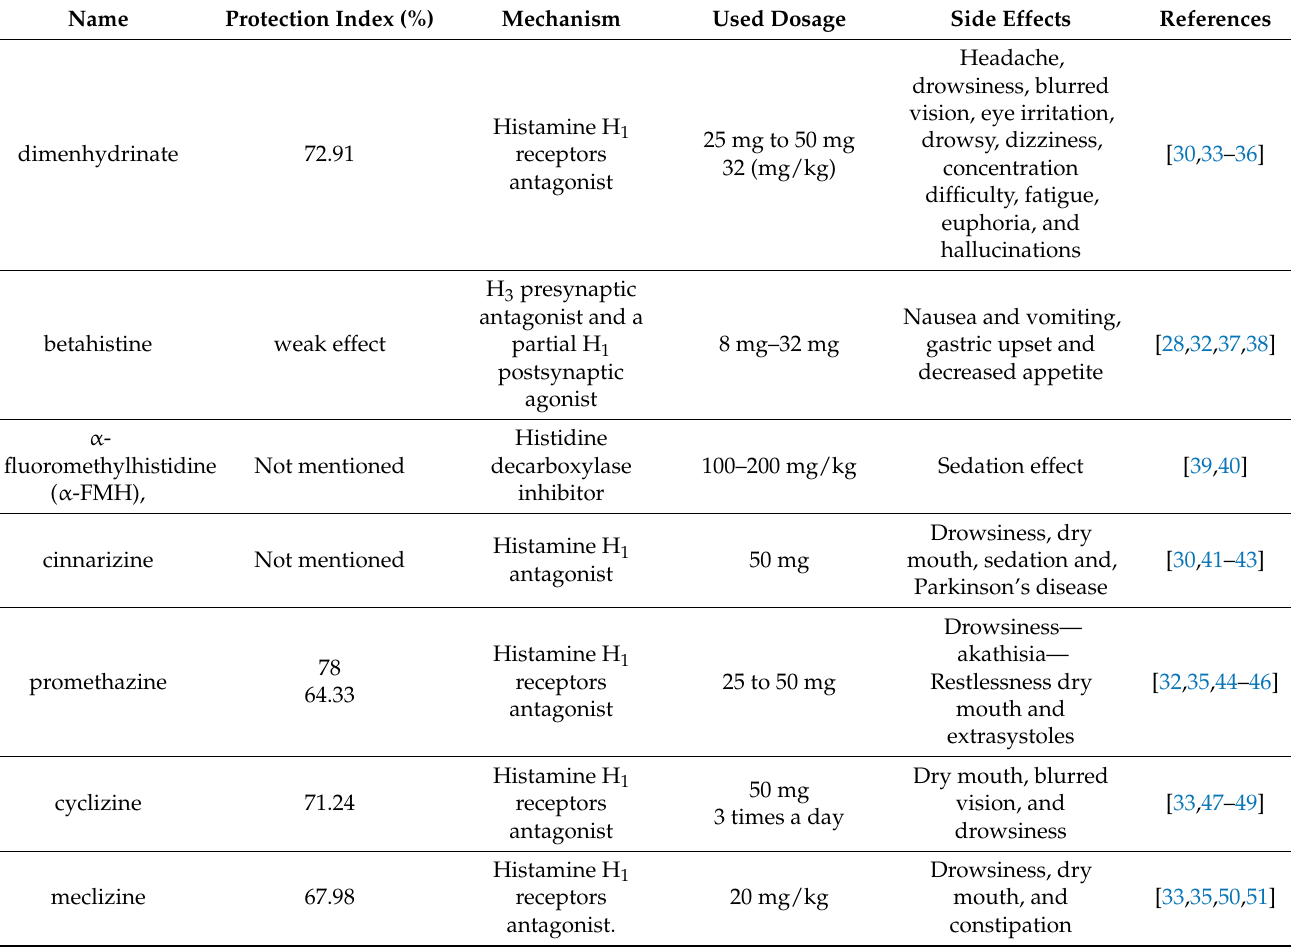
Table 1. Table 1. Common pharmacological treatments in inhibiting Motion